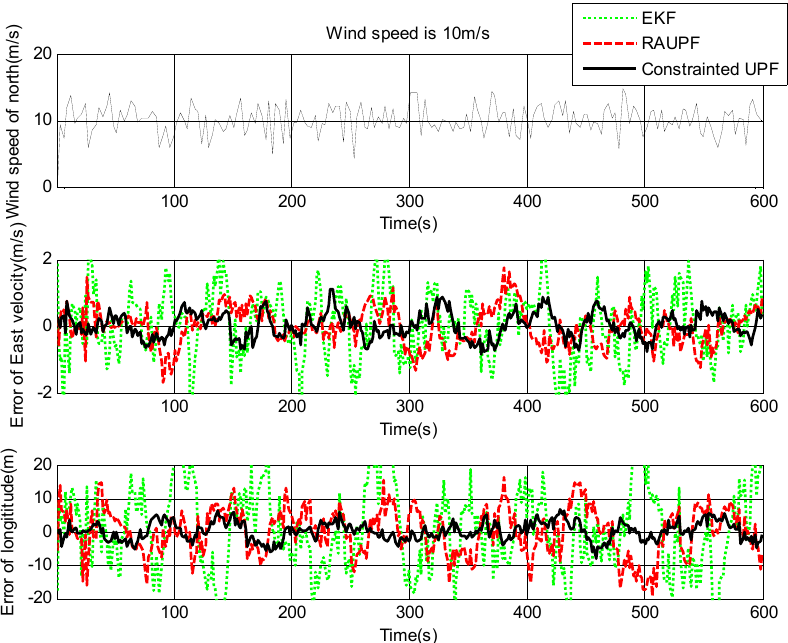
Figure 3. East velocity and longitude errors under the wind speed of 10 m/s.